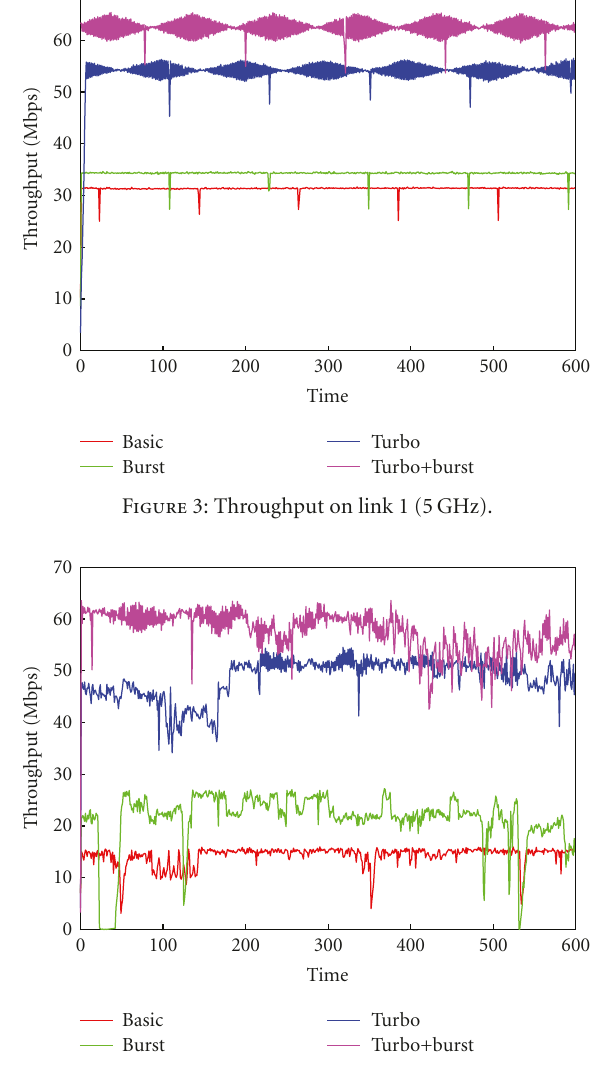
Figure 4: Throughput on link 3 (2.4GHz).